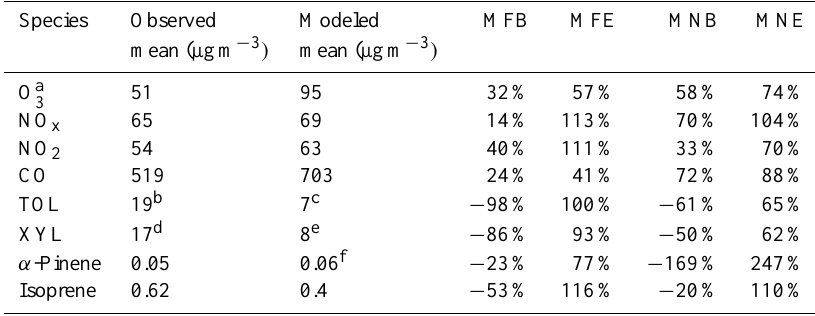
Table 4. Statistical performance evaluation for O 3 , NO 2 , NO x , CO and some VOC at USJ for the simulation A1. Species Observed Modeled MFB MFE MNB MNE mean (µgm − 3 ) mean (µgm − 3 ) O a 51 95 32% 57% 58% 74% 3 NO x 65 69 14% 113% NO 2 54 CO